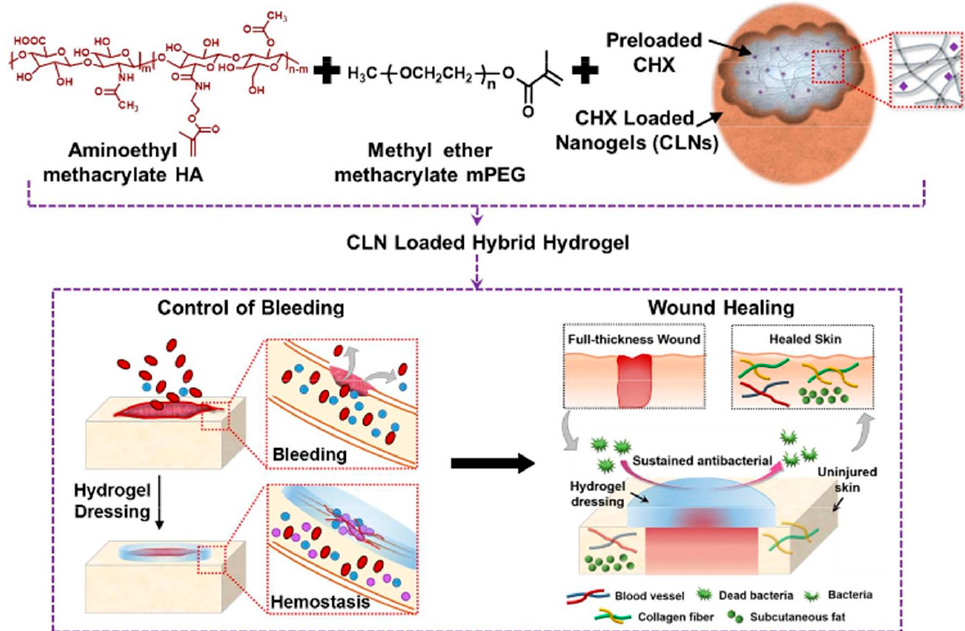
Figure 10. CLN-loaded hybrid hydrogel constructed from aminoethyl methacrylate HA, methyl ether methacrylate mPEG and CHX loaded nanogels (CLNs). The hydrogel enables controlled antibiotic release and accelerates wound healing. From [78].